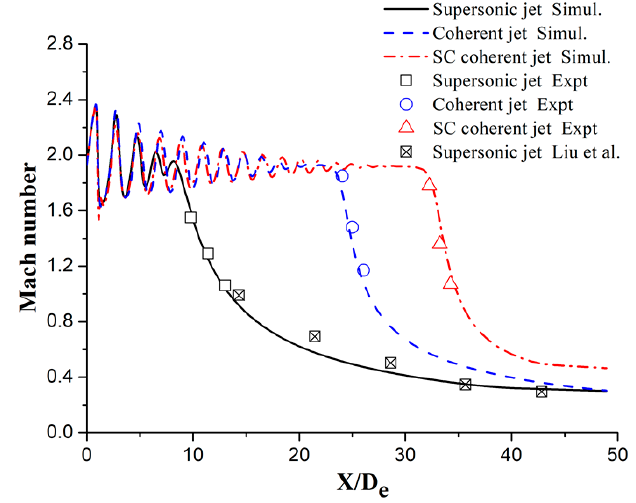
Figure 5. Axial Mach number of the main oxygen jet for different jets.